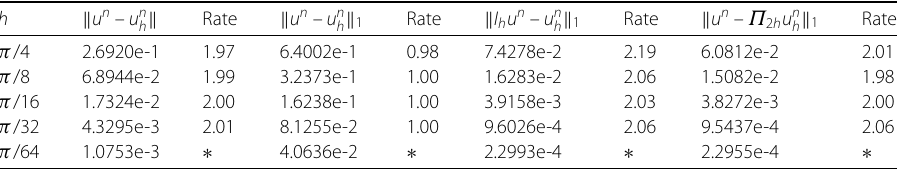
and α = 0.3 at 100